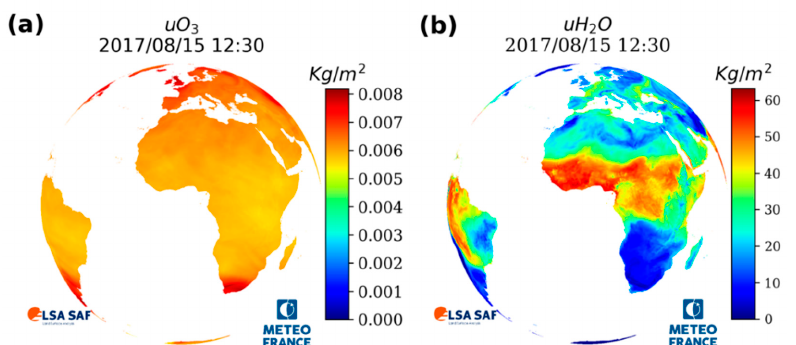
Figure 4. Example of ( a ) the Total Ozone Column content (in kg / m 2 ) and ( b ) the total column water vapor content (in kg / m 2 ) for the 15th of August 2017 at 12:30 UTC, derived from the ECMWF-IFS forecasts.